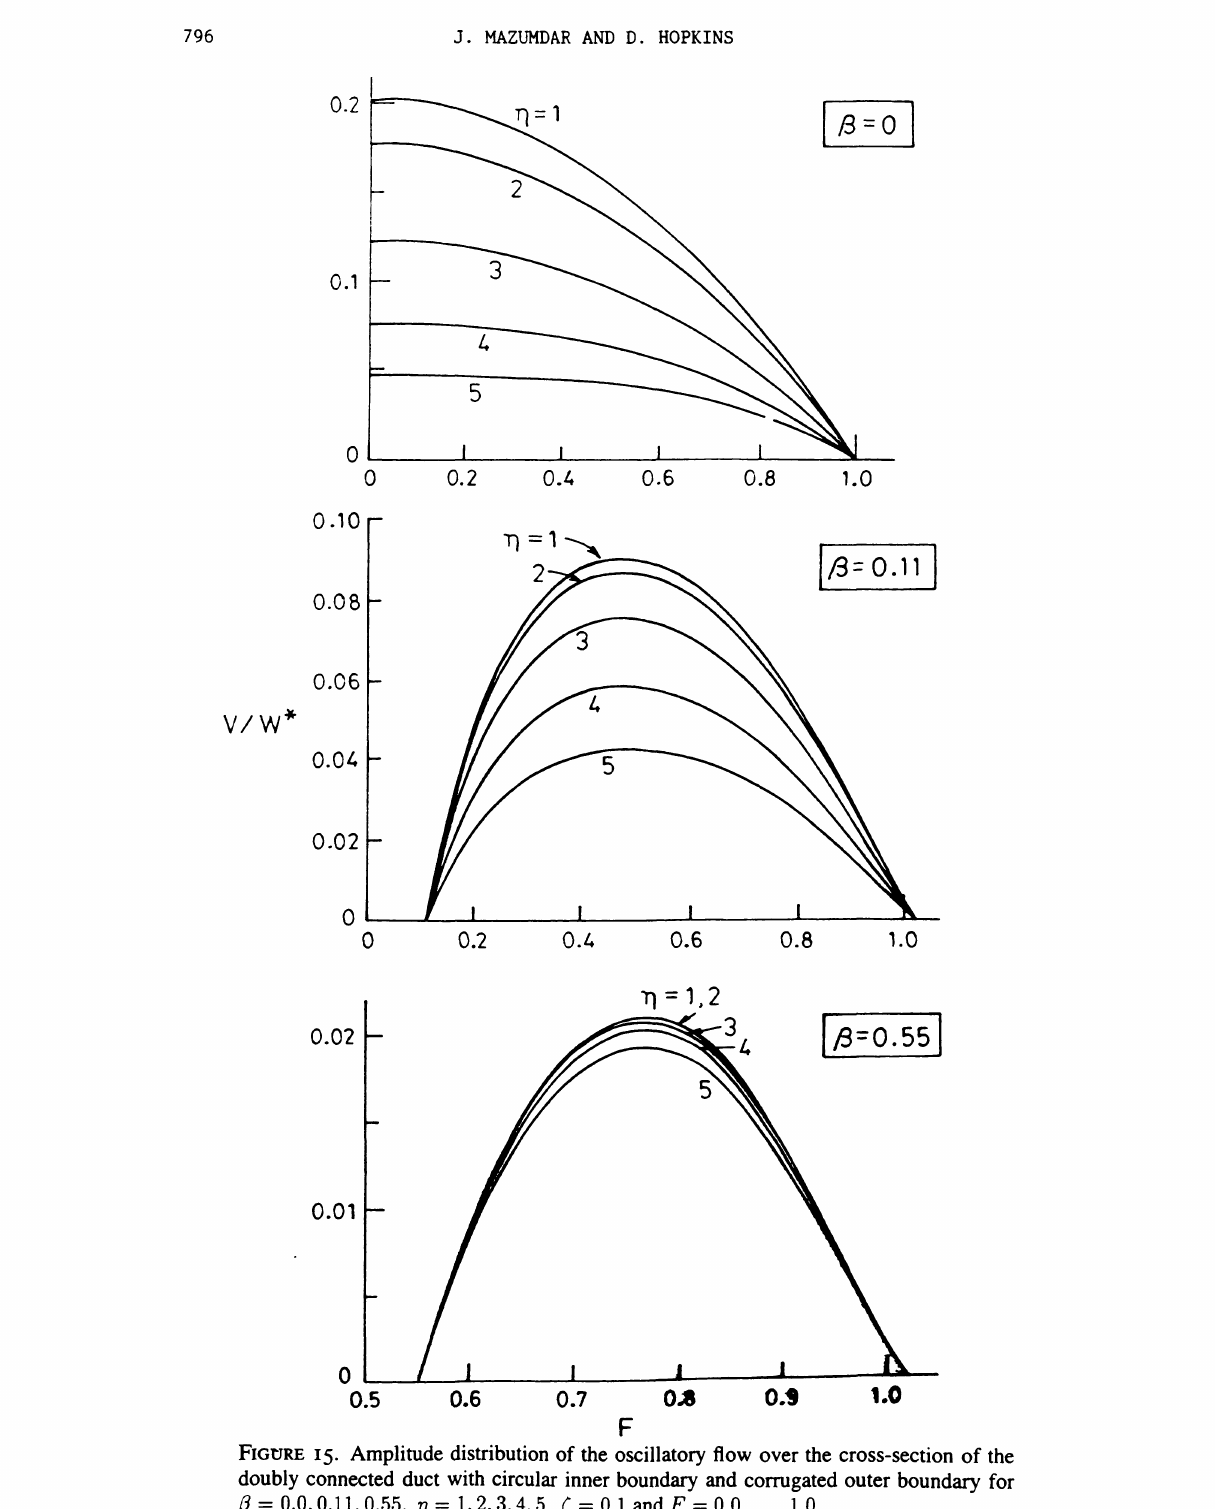
FIGURE I5. Amplitude distribution of the oscillatory flow over the cross-section of the doubly connected duct with circular inner boundary and corrugated outer boundary for 3=0.0,0.11,0.55, ,= 1,2,3,4,5, =0.1